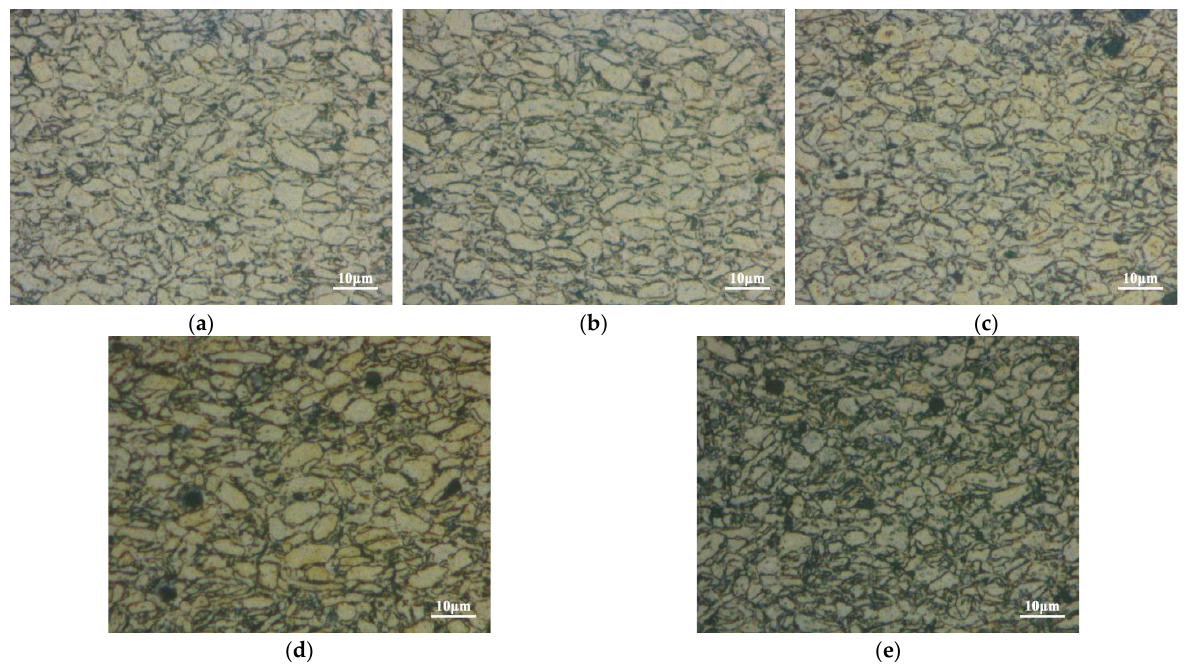
Figure 5. Microstructures of CNT/Mg composites with different contents of CNTs: ( a ) 0.5 vol.%; ( b ) 1 vol.%; ( c ) 1.5 vol.%; ( d ) 2 vol.%; ( e ) 2.5 vol.%. Figure 6 shows the TEM images of CNT/Mg composites with 1% CNTs. Figure 6a shows some separately distributed CNTs, proving that the CNTs are uniformly distributed in the matrix. Additionally, it can be seen that some small particles measuring about 10 nm are diffusely distributed in the matrix (in virtual frame B). This area is shown at high magnification in Figure 6b. An analysis of the atom-packed layer spacings shows that they are 0.2 nm and 0.21 nm, corresponding to the (114) and (202) planes of Mg 2 Ni,